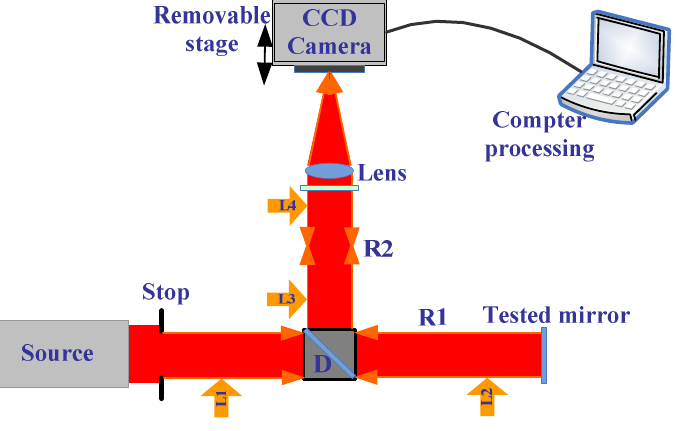
Figure 4. The optical path of testing the plane mirror.